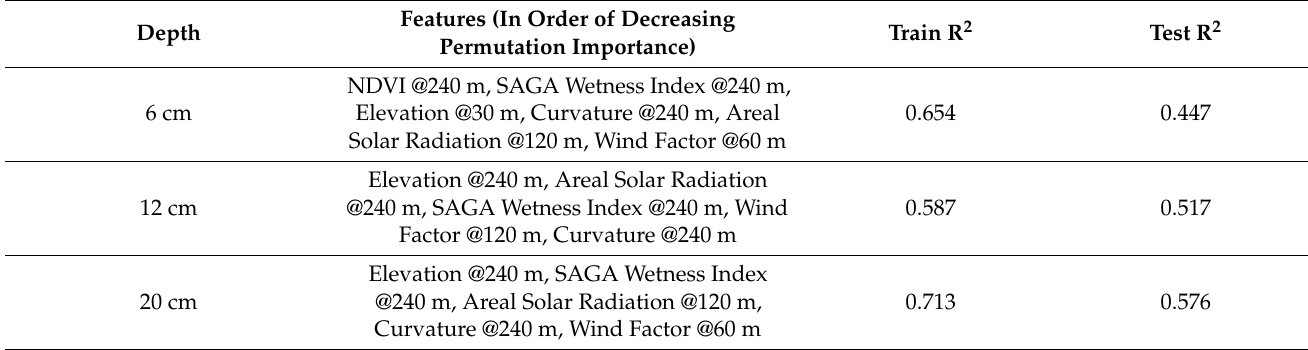
Table 1. Final random forest model parameters and